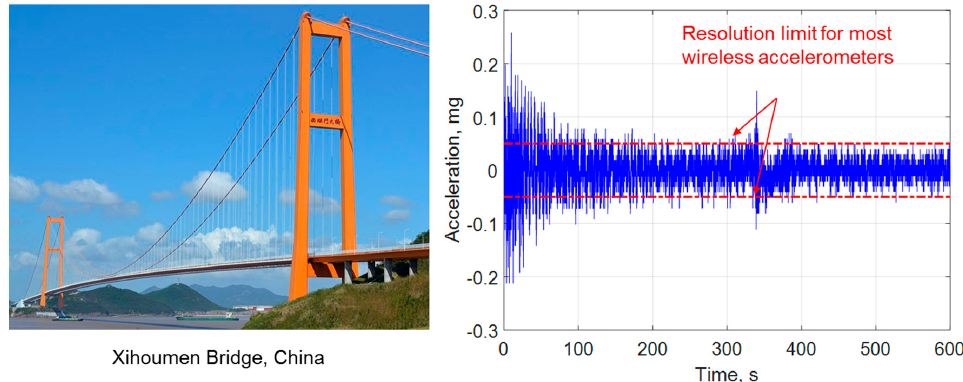
Figure 1. Lateral acceleration response at the midspan of the deck on the Xihoumen Bridge in China [5].